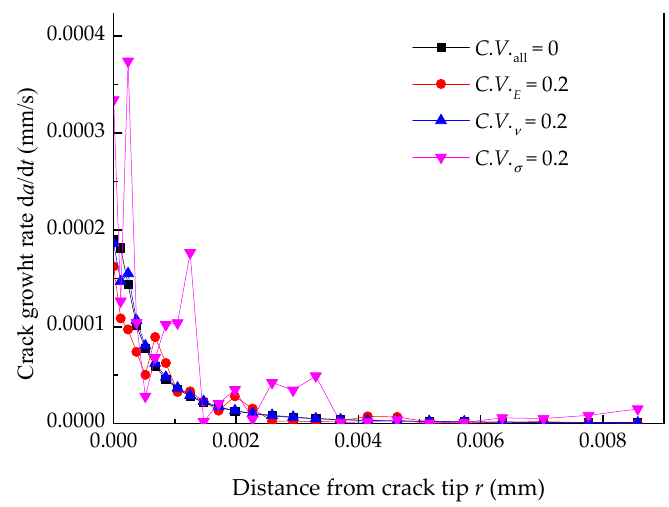
Figure 9. Crack growth rate under a single random material factor.